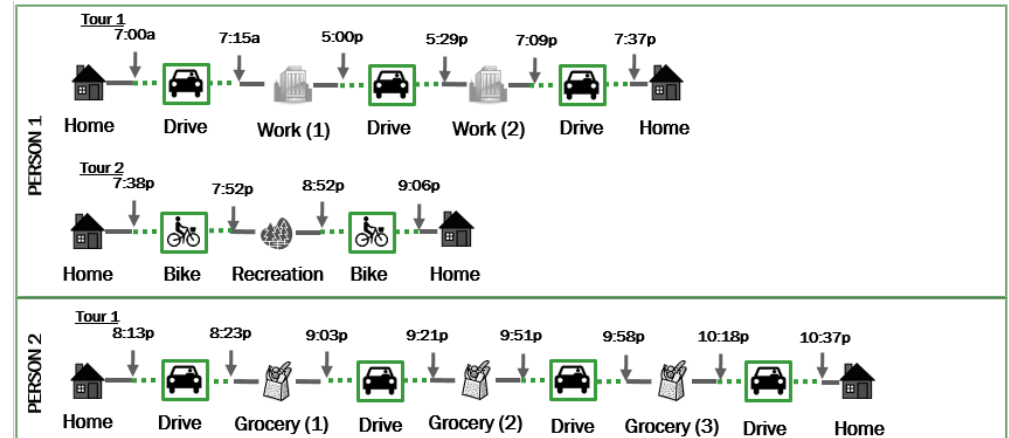
Figure 3. Modelled Schedule of Activities and Trips of Drivers The model assigned the vehicle to Person 1 who had the higher priority activity. In reality, he cycled to work, which allowed Person 2 to drive to the grocery activities in the morning, instead of the modelled evening trips. This outcome illustrates that the model process is working correctly, however, it did not capture the particular mode preferences of Person